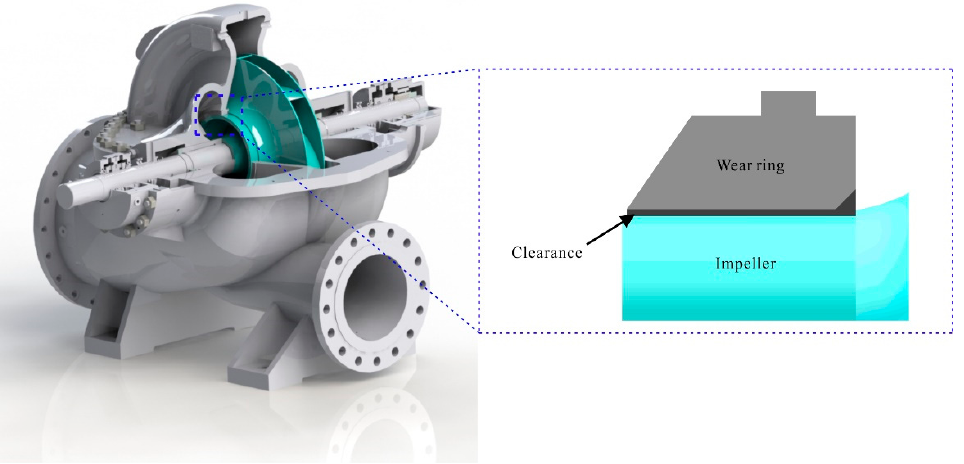
Figure 1. Schematic diagram of a certain type of water pump and impeller-wear ring friction pair.